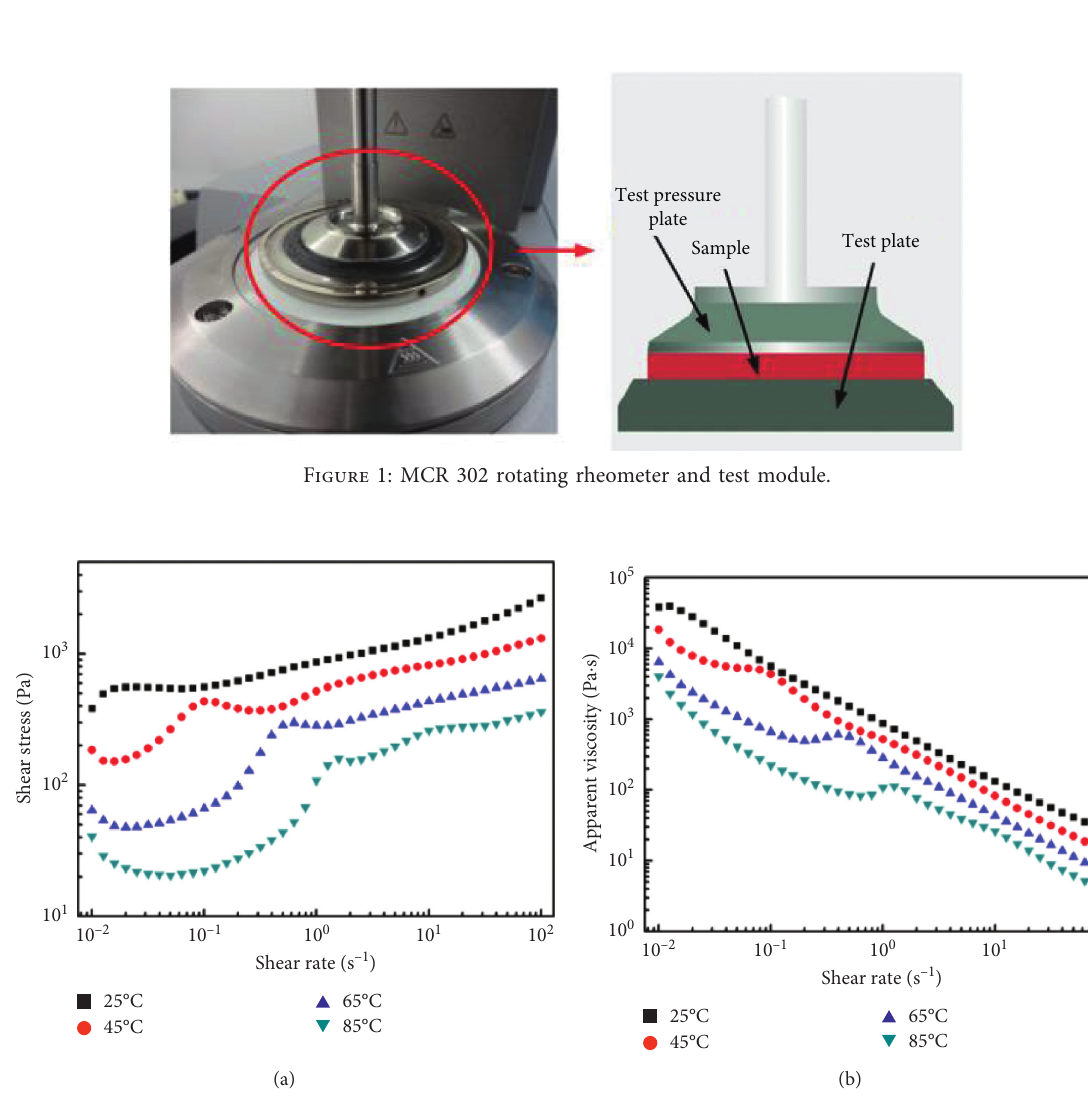
Figure 2: Variation of shear stress and apparent viscosity of the grease with shear rate at different temperatures for (a) curve of the shear stress with the shear rate and (b) curve of the apparent viscosity with the shear rate.